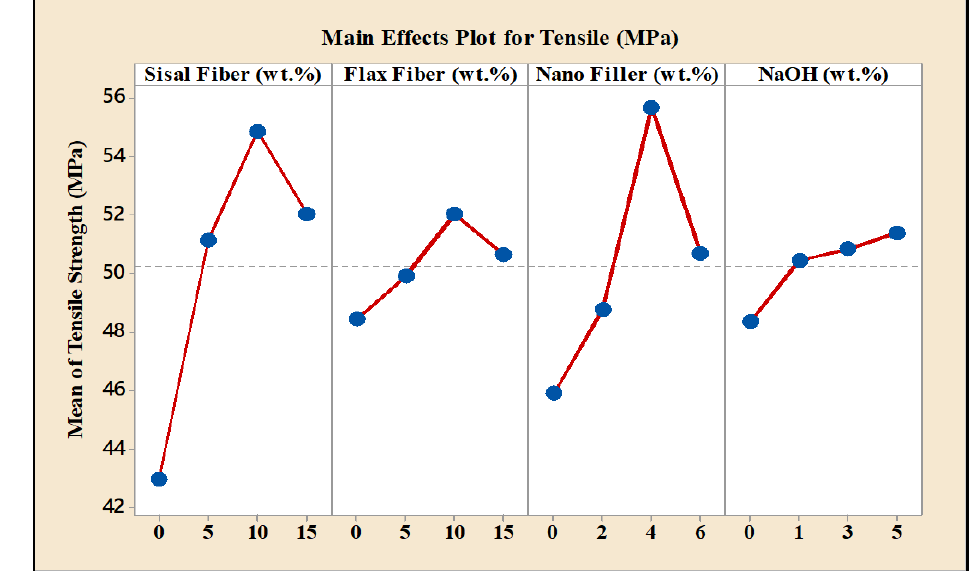
Figure 9. Mean Values of Tensile Behaviour of Hybrid Composites with various input parameters .